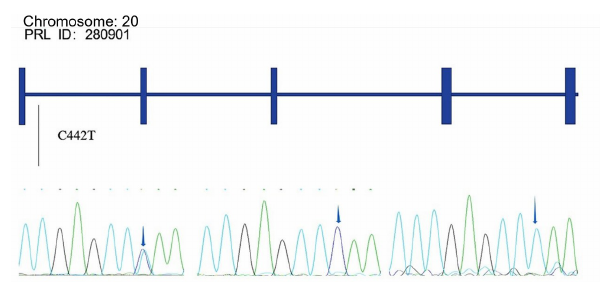
Figure A1. Partial chromatogram of SNP locus of PRL gene in Liaoning cashmere goat.